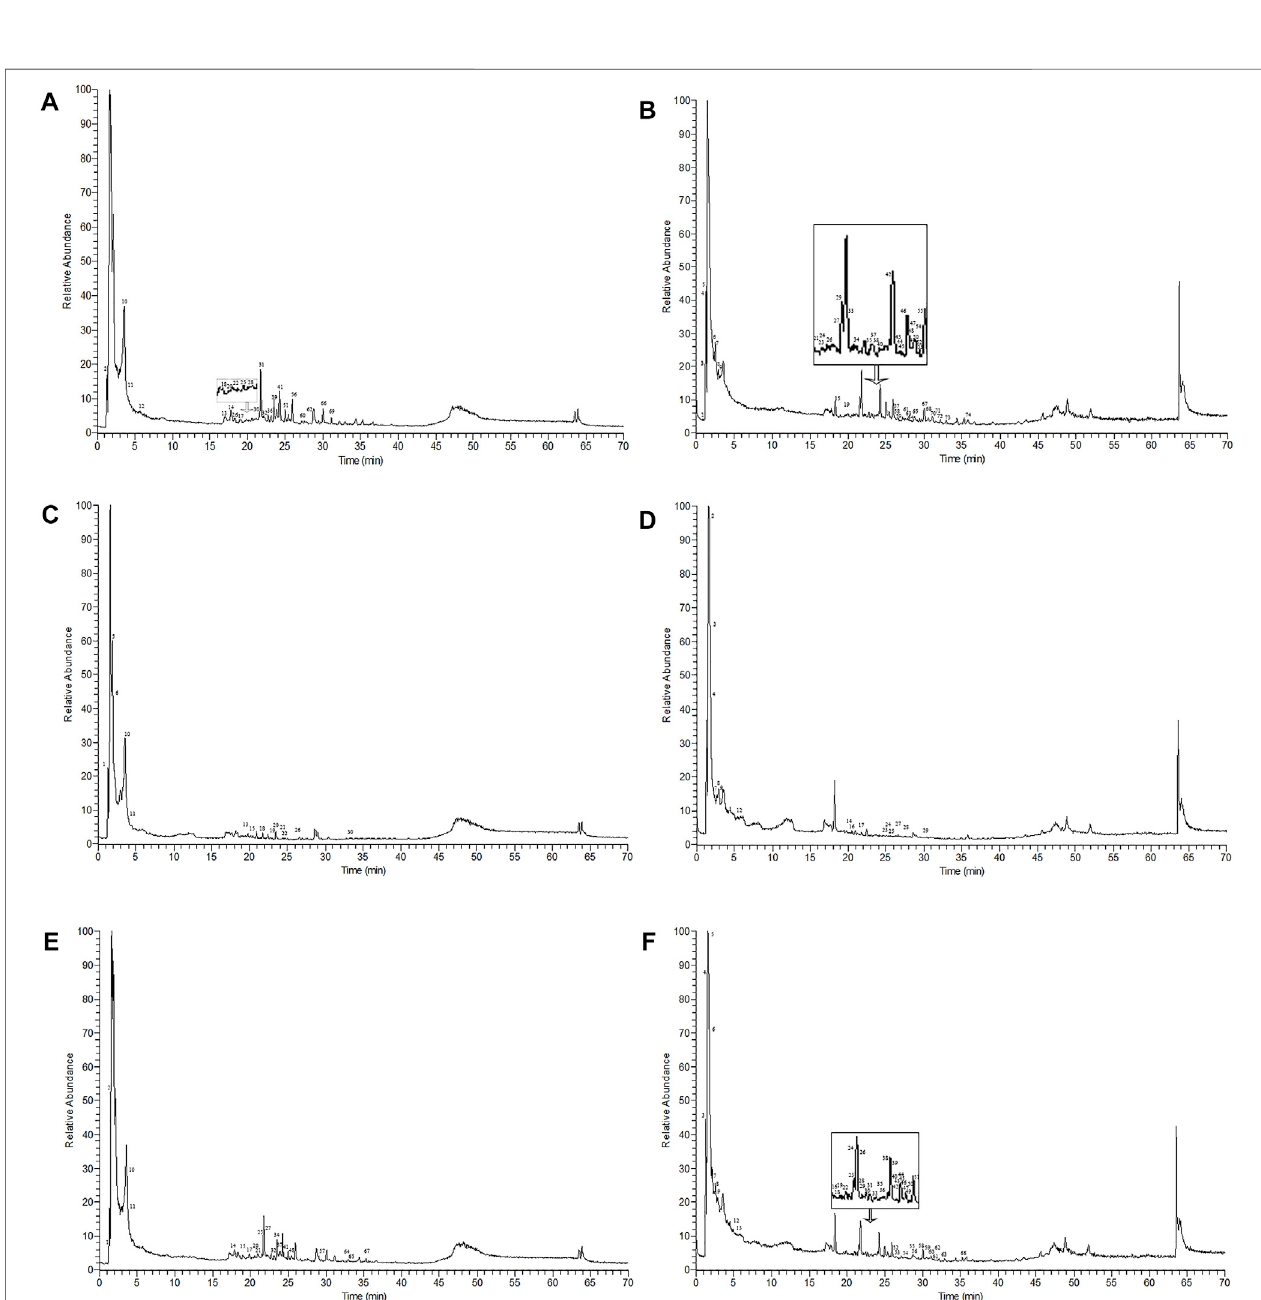
FIGURE1| MassspectraofAMD, RTD,andcompatibility ofAMDandRTDinnegativeandpositiveionmodes. (A) MassspectraofAMDinthenegativeionmode. (B) Mass spectra of AMD in the positive ion mode. (C) Mass spectra of AMD in the negative ion mode. (D) Mass spectra of RTD solutions in the positive ion mode. (E) MassspectraofthecompatibilityofAMD andRTDwitharatioof5:3inthenegativeionmode. (F) MassspectraofthecompatibilityofAMDand RTDwitharatioof5:3in the positive ion mode.